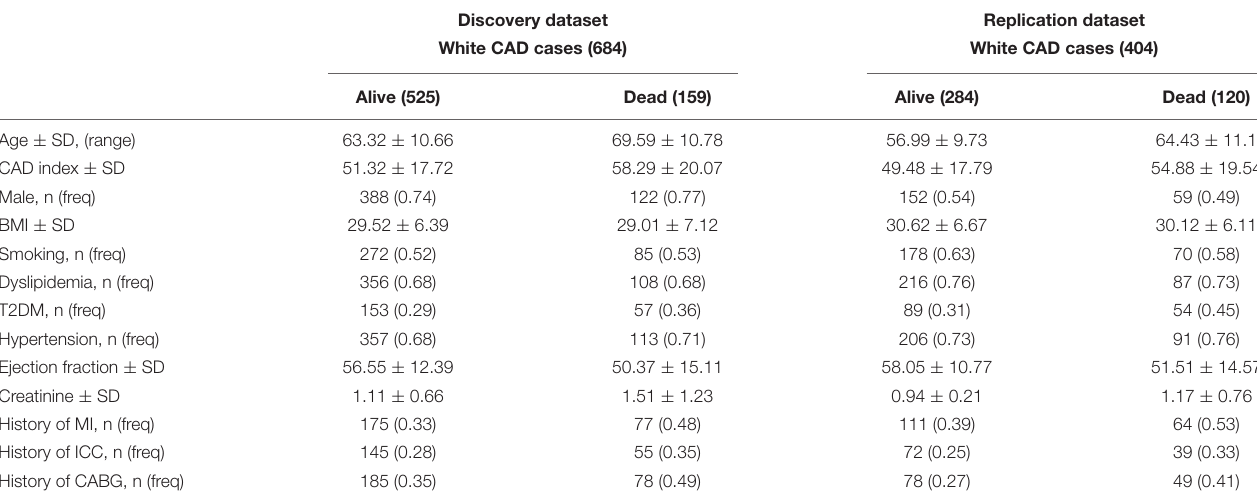
TABLE 1 | Participant